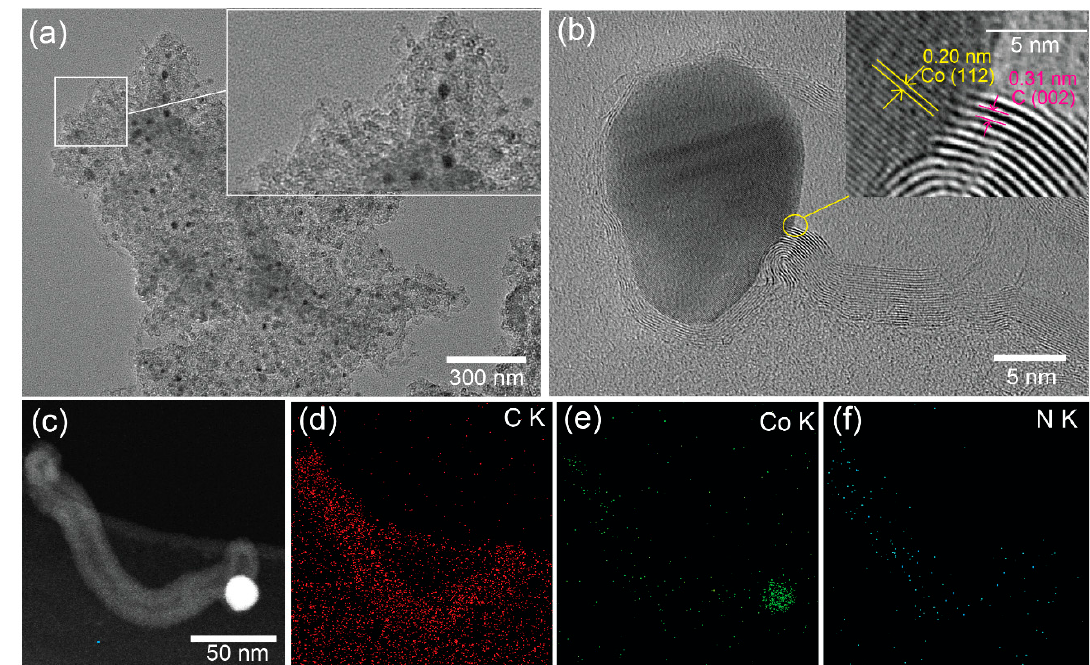
Figure 2. ( a ) TEM image of Co@CNTs-800; ( b ) High resolution TEM image of Co@CNTs-800; ( c – f ) Elemental mapping images of Co@CNTs-800.